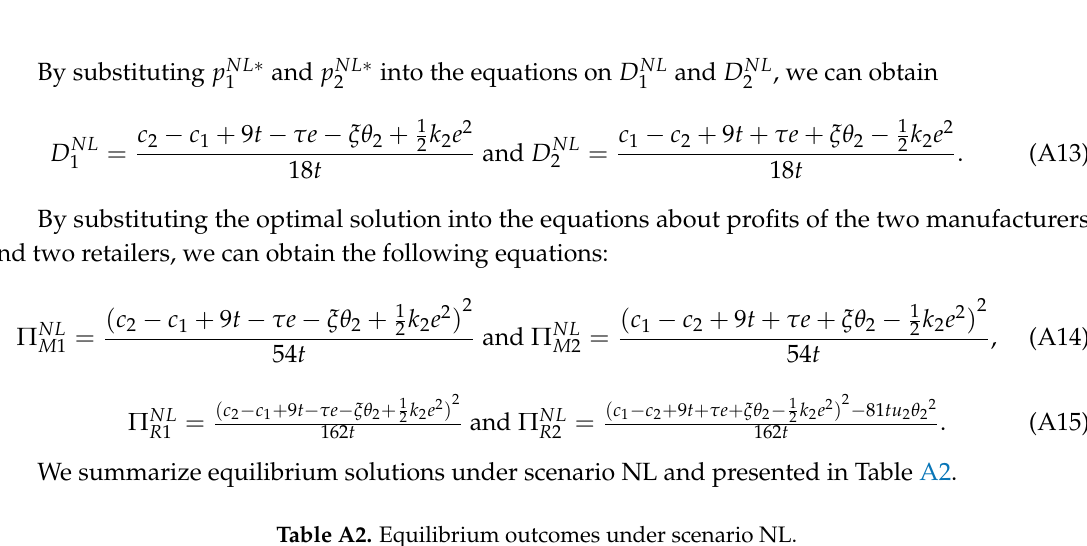
Table A2. Equilibrium outcomes under scenario